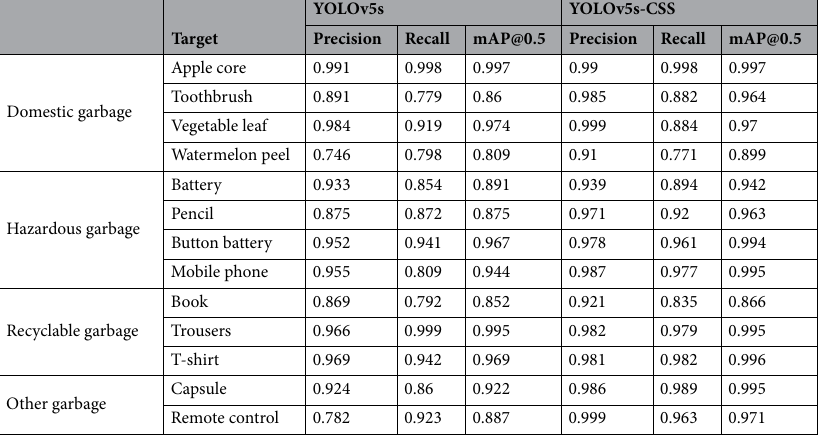
YOLOv5s YOLOv5s-CSS Target Precision Recall mAP@0.5 Precision Recall mAP@0.5